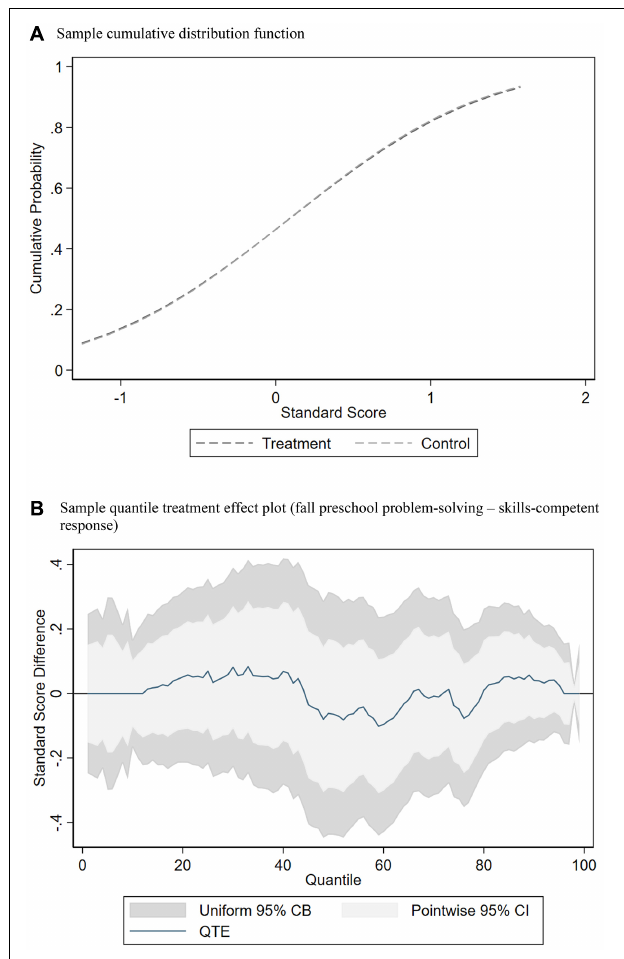
FIGURE 1 | Example of randomization imbalance in the CARES study for comparison of socio-emotional curricula classrooms compared with business-as-usual classrooms on social problem-solving skills (competent response) standard scores at baseline (fall). (A) Sample cumulative distribution function. (B) Sample quantile treatment effect plot (fall preschool problem-solving skills – competent response).